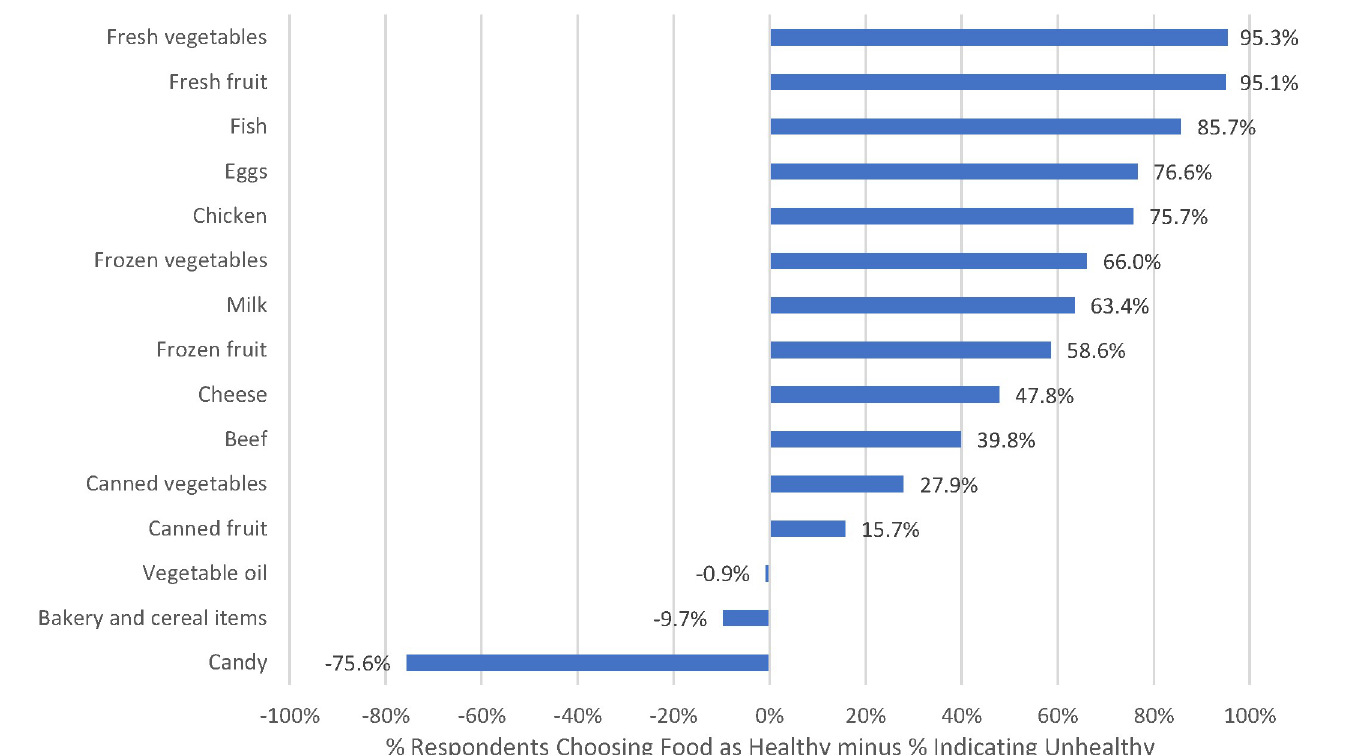
Fig 2. Perceived healthiness of 15